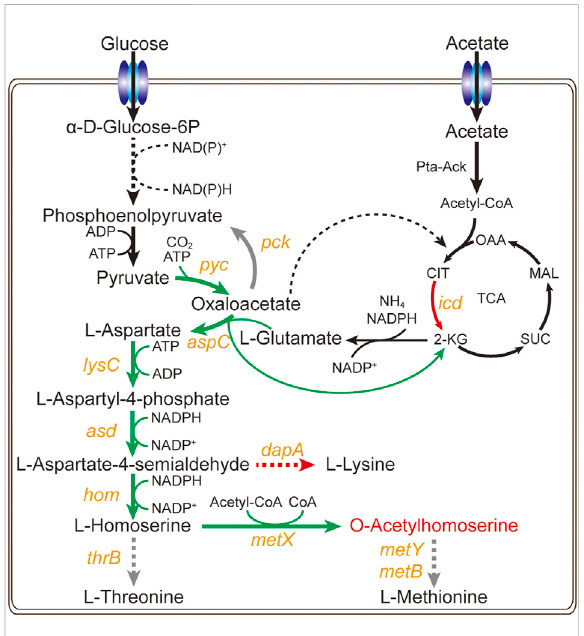
Metabolic engineering strategy for construction of the OAH- producing strains. Yellow italics represent genes. The black arrows represent the unmodi fi ed pathways, the grey arrows represent the knockout pathways, the green arrows represent the up- regulated pathways, the red arrows represent the down-regulated